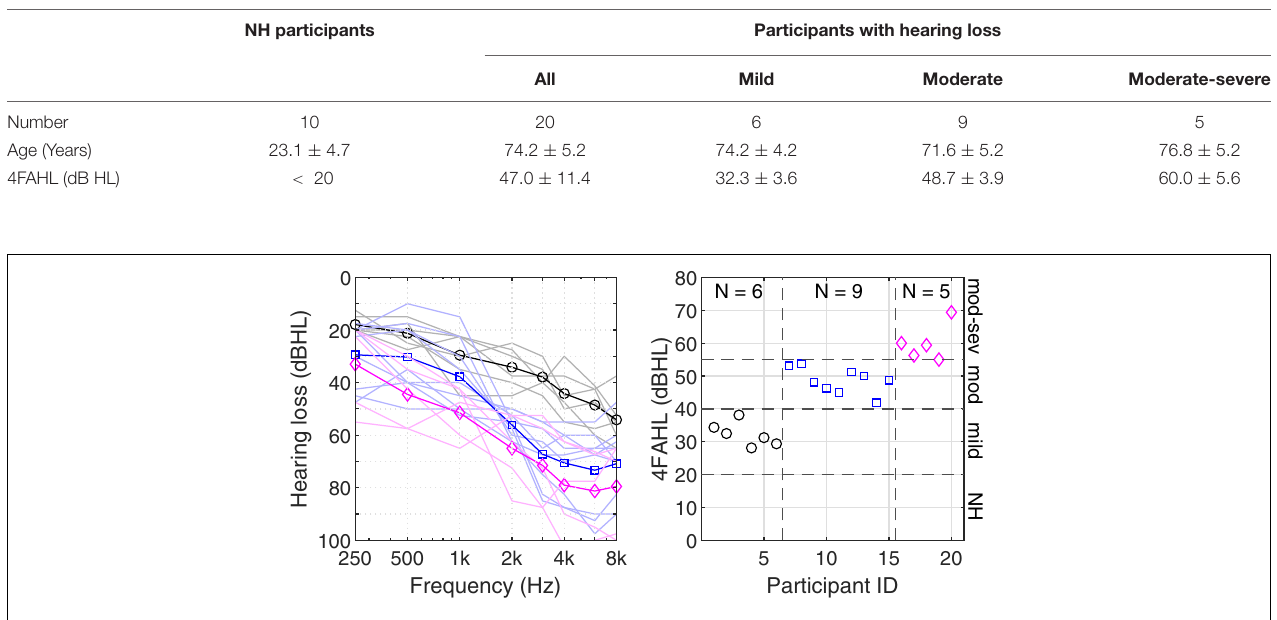
FIGURE 1 | Pure-tone audiograms of the participants with hearing loss averaged across ears (left panel) and their corresponding 4FAHL (right panel). The thin lines in the left panel refer to the individual audiograms and the thick lines with symbols to the audiograms averaged within groups.